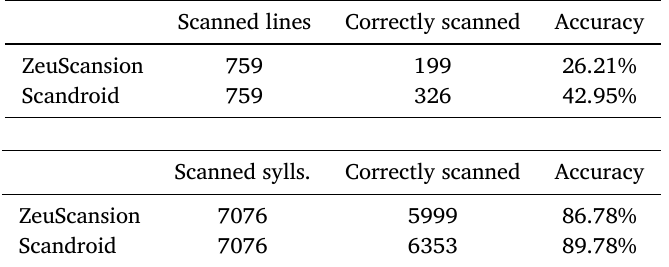
ZeuScansion evaluation results against the For Better For Verse corpus